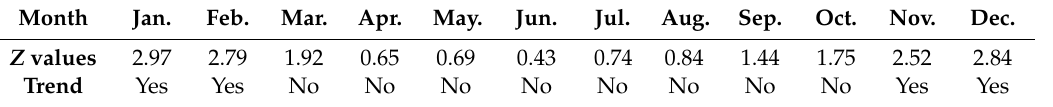
Table 3. Trend analysis results for evaporation ( Z